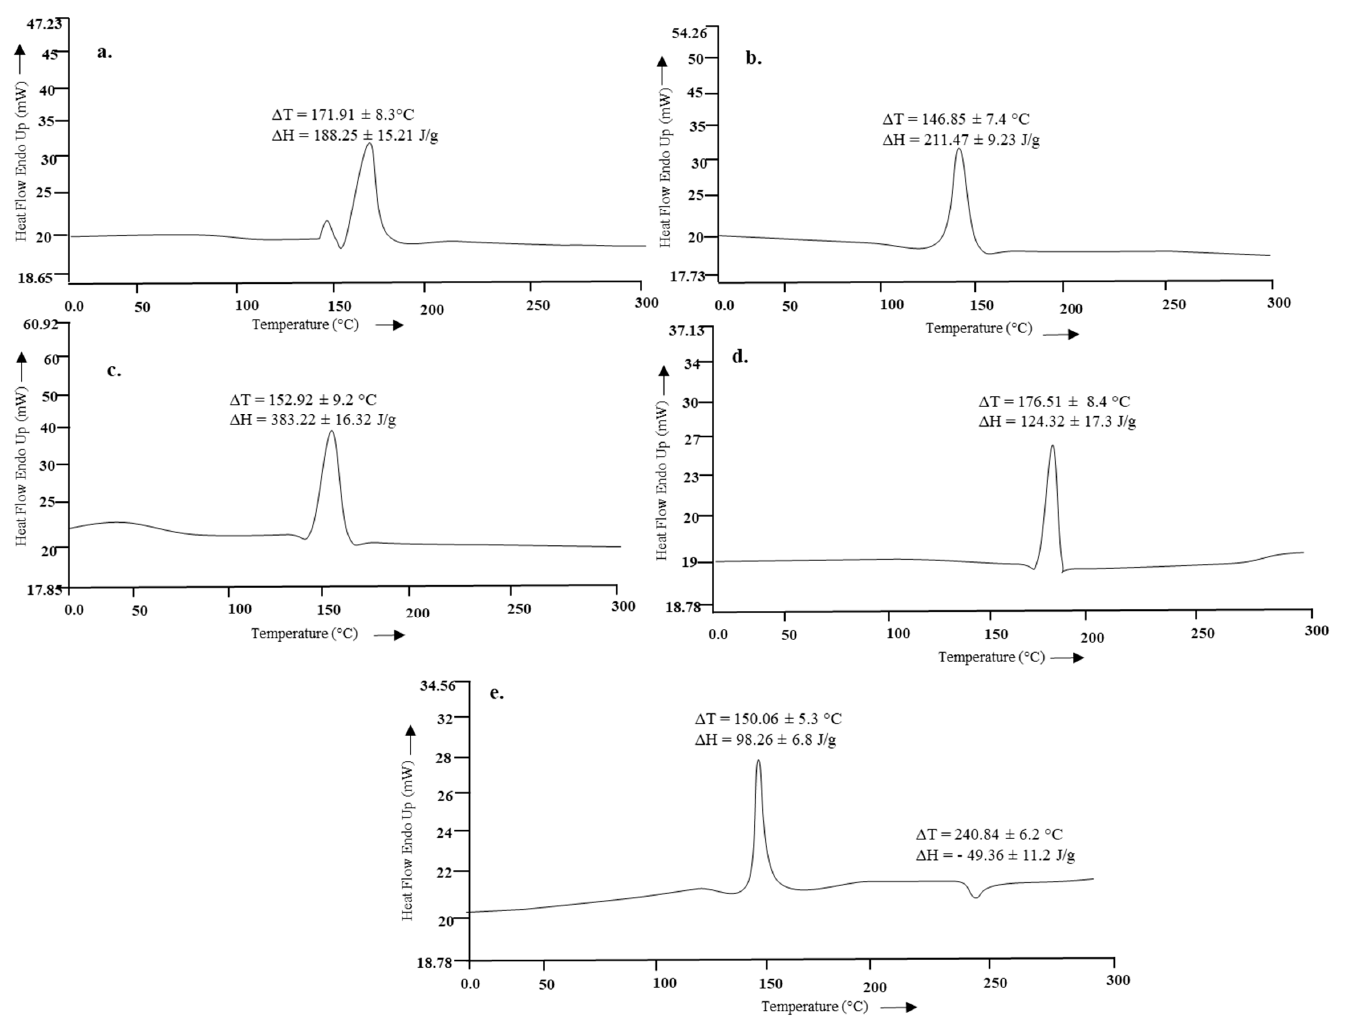
Figure 4. Thermal analysis of ( a ) parent chitosan, ( b ) microwave treated chitosan, ( c ) blank F2, ( d ) curcumin, ( e ) F2.